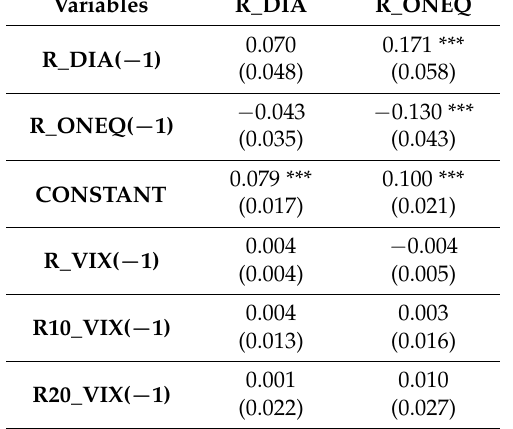
Table 22. Mean Equation for US Market ETF and VIX (After GFC) (1 April 2009 to 30 March 2015). Variables